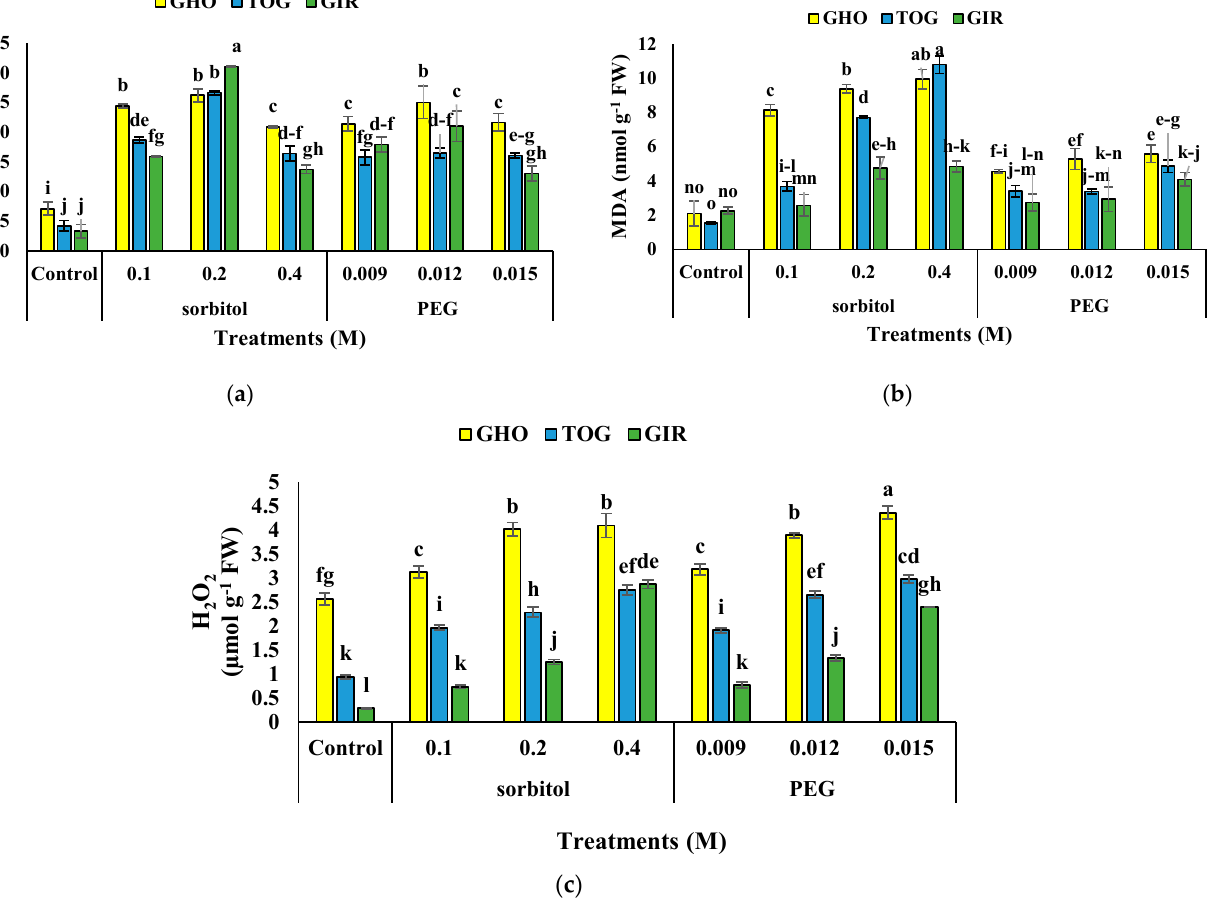
Figure 1. Effects of PEG and sorbitol on proline ( a ), MDA ( b ), and H 2 O 2 content ( c ) of 3 melon genotypes. Different letters are significantly different based on Duncan’s multiple range test ( p ≤ 0.05). GHO, TOG, and GIR are the Ghobadloo, Girke, and Toghermezi genotypes, respectively. 2.6. TAA